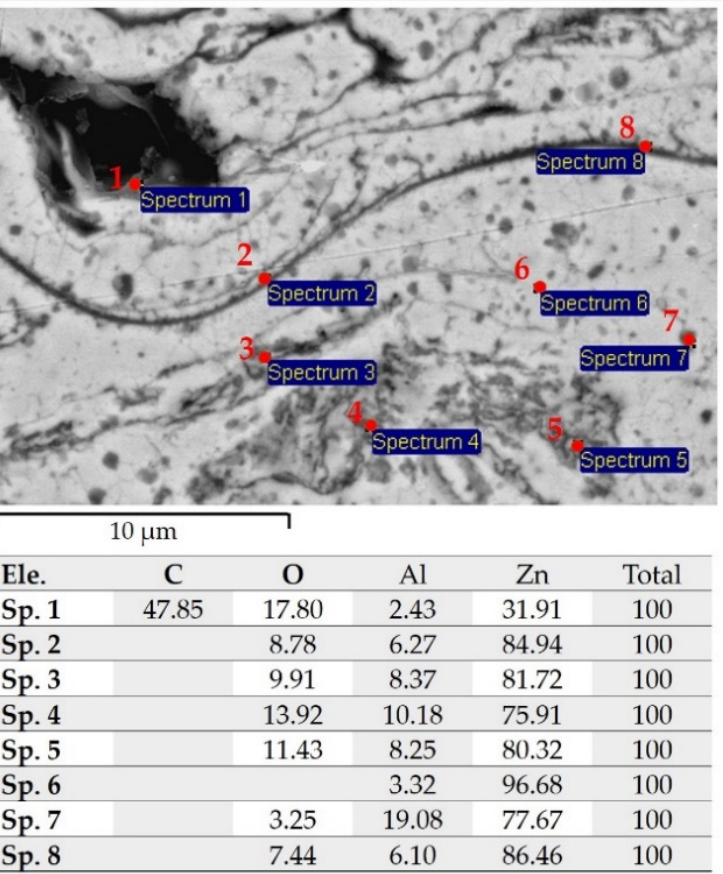
Figure 13. SEM images of the crack zones in near-surface zones of MHP post-treated coatings produced by using compressed air as atomization gas.